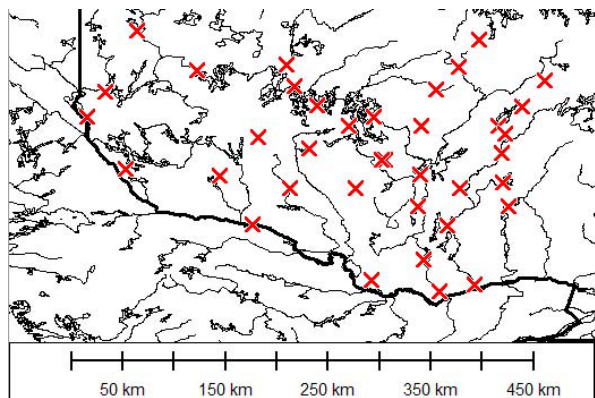
Fig. 13. Snow survey stations used for